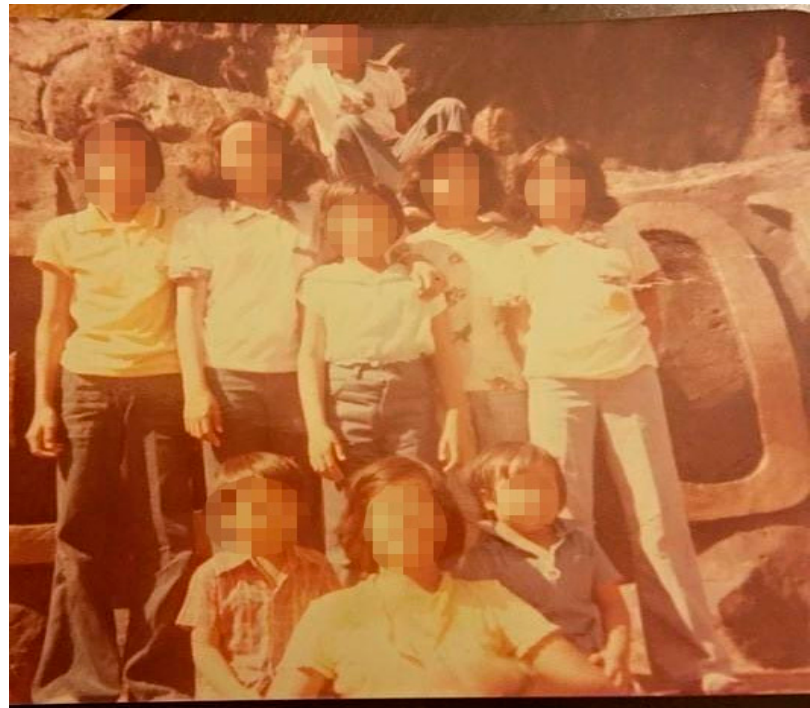
Figure 2 . Sarah’s photo 1978, “not just cousins, but more like family, really!” .